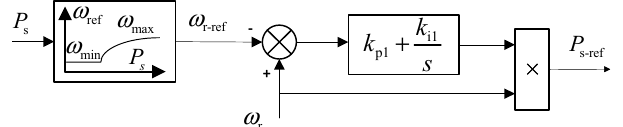
Figure 4. Control diagram of DFIG rotor speed control.